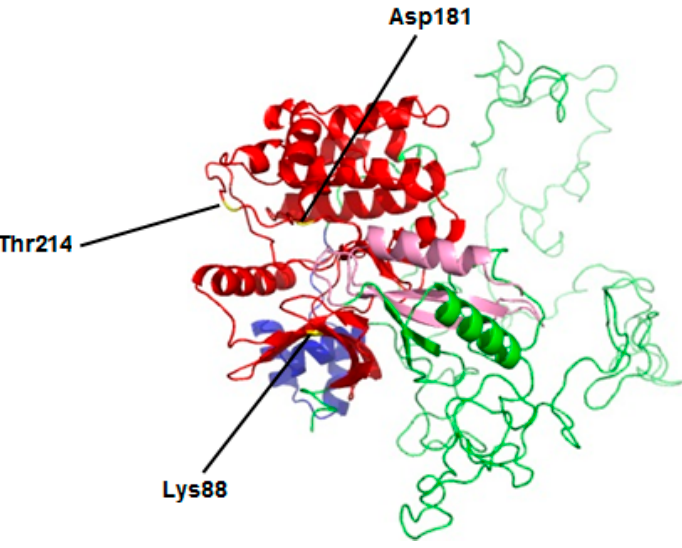
Figure 1. The tertiary protein structures of MARK4 protein in Pig ( Sus scrofa ) modeled by the ProModII program. Kinase domain (KD) colored red, ubiquitin-associated domain (UBA) is blue and kinase associated domain1 (KA1) in pink.